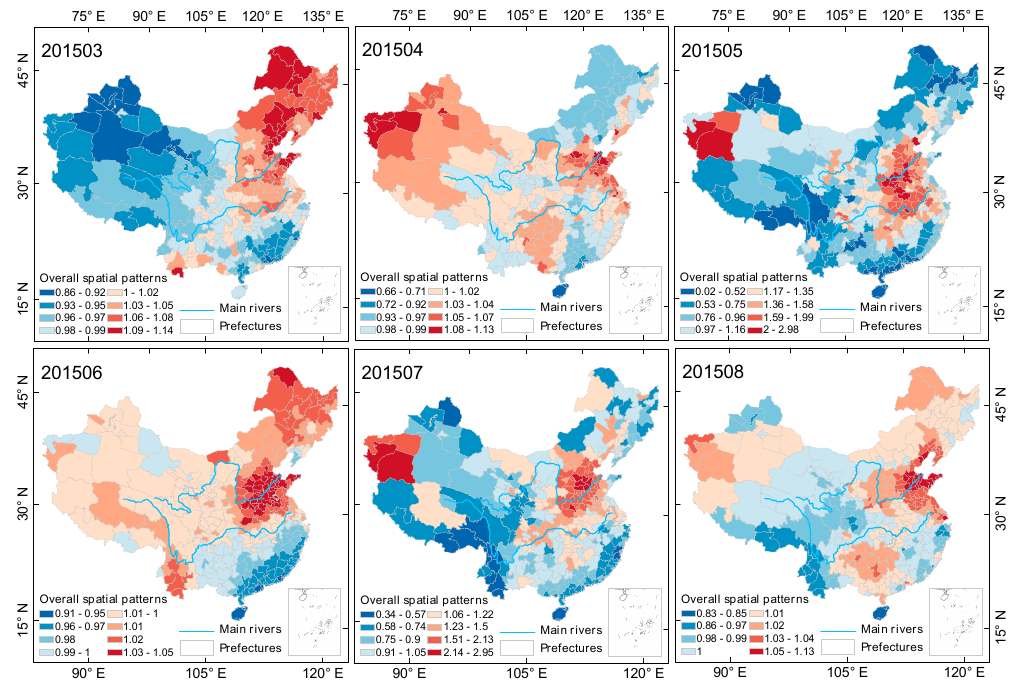
Figure 8. Evolution of spatial relativity of PM 2.5 pollution over the Chinese mainland (not including Taiwan) during the spring-summer season of 2015.